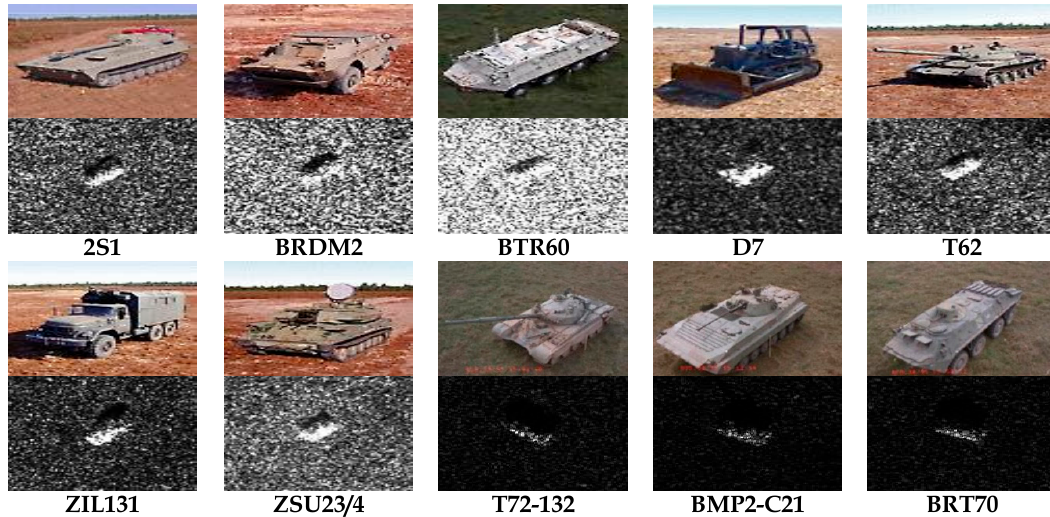
Figure 7. The optical and SAR images of ten targets to be recognized. The descriptions of these vehicles can be referred to [21].